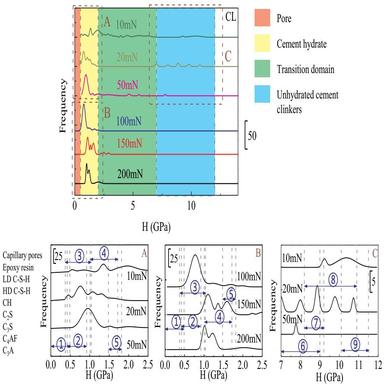
Hardness distributions of the HCP from the CL scratches with different maximum loads, where these in the range of 0–2.5 GPa with the low (10, 20 and 50 mN) and high loads (100, 150 and 200 mN) are plotted in subpanels A and B, respectively; and these in the range of 7–12 GPa with the low loads (10, 20 and 50 mN) are plotted in subpanel C.